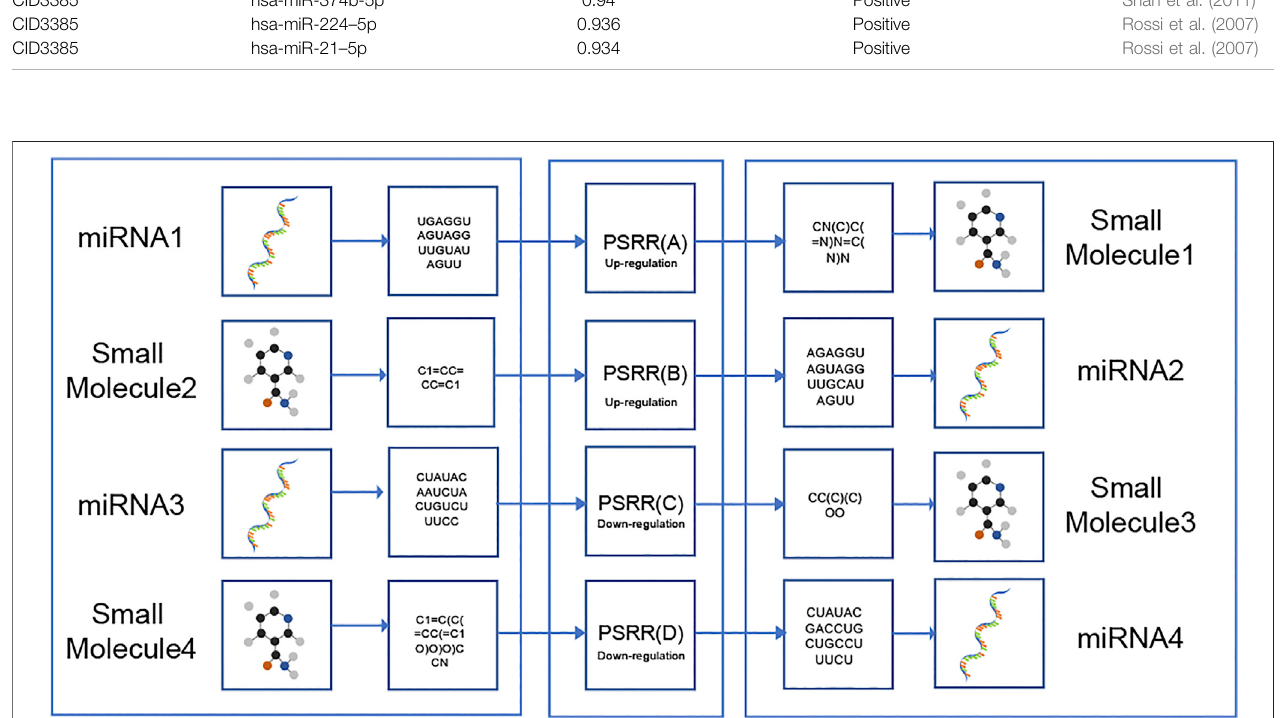
FIGURE 5 | Work fl ow of PSRR. The PSRR (A) module takes as input a miRNA sequence and yields SMILES strings of small molecules that could increase the expression of this miRNA. The PSRR (B) module takes as input the SMILES string of a small molecule and yields sequences of miRNAs that could be decreased by this smallmolecule.ThePSRR (C) moduletakesasinputamiRNAsequenceandyieldsSMILESstringsofsmallmoleculesthatcoulddecreasetheexpressionofthismiRNA. ThePSRR (D) moduletakesasinputtheSMILEstringofasmallmoleculeandyieldssequencesofmiRNAsthatcouldbedecreasedbythissmallmolecule.Inallthe four modules, predicted regulation probabilities (0 – 1) were generated and